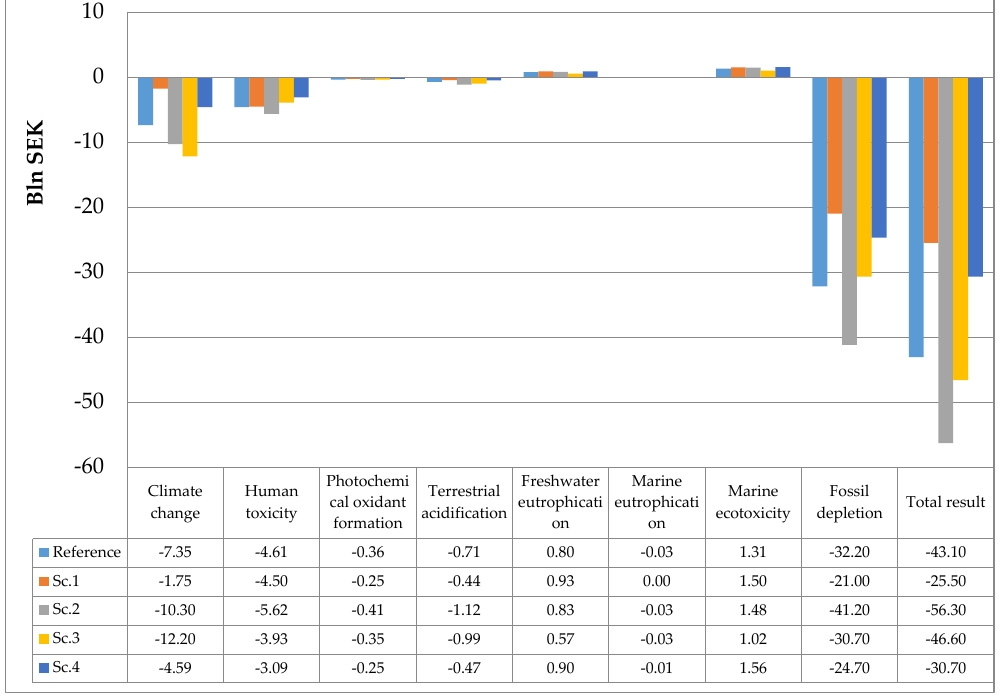
Figure 4. Valuation results for the different scenarios using the Ecovalue method.